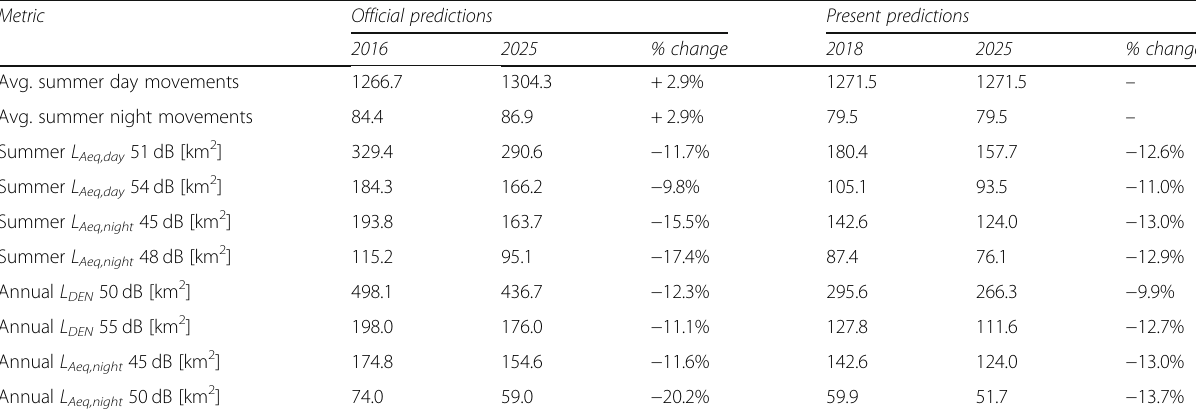
Table 3 Official and present predictions at Heathrow Airport for 2025